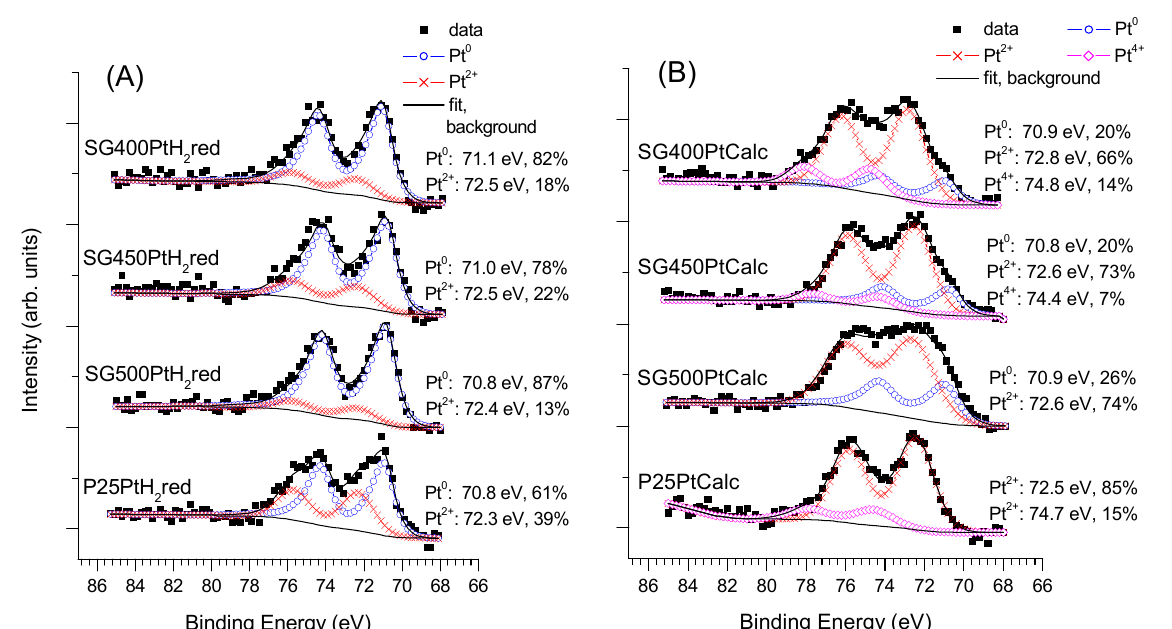
Figure 7. Pt 4f spectra of the fresh Pt-PtO x /TiO 2 catalysts formed by ( A ): H 2 reduction and ( B ): calcination. Spectra were recorded after cca. 1 h X-ray exposure.